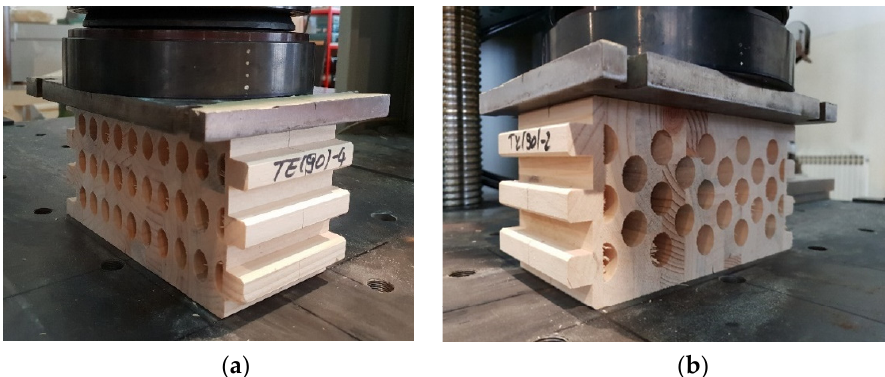
Figure 23. Timber samples during the experimental test of compression strength perpendicular to the grain in the direction of the stronger axis. ( a ) elliptical cavities; ( b ) circular cavities. Again, samples with ellipse-shaped cavities, marked TE(90)-n, and circular cavities, marked TK(90)-n, were tested. The notation (90) represents compression in the direction of the stronger axis, while “n” represents the number of the tested sample. In Figures 24–26, the results, according to the data obtained by tests, are shown.